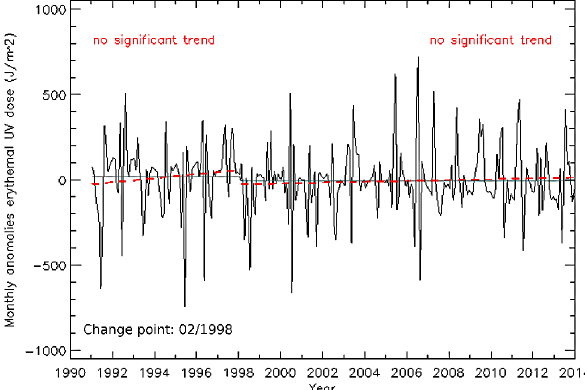
Figure 5. The black line represents the detrended time series of monthly anomalies of erythemal UV dose (1991–2013). The red (dashed) lines represent the (insignificant) positive trends before and after the detected change point. The grey lines represent the mean before and after the change